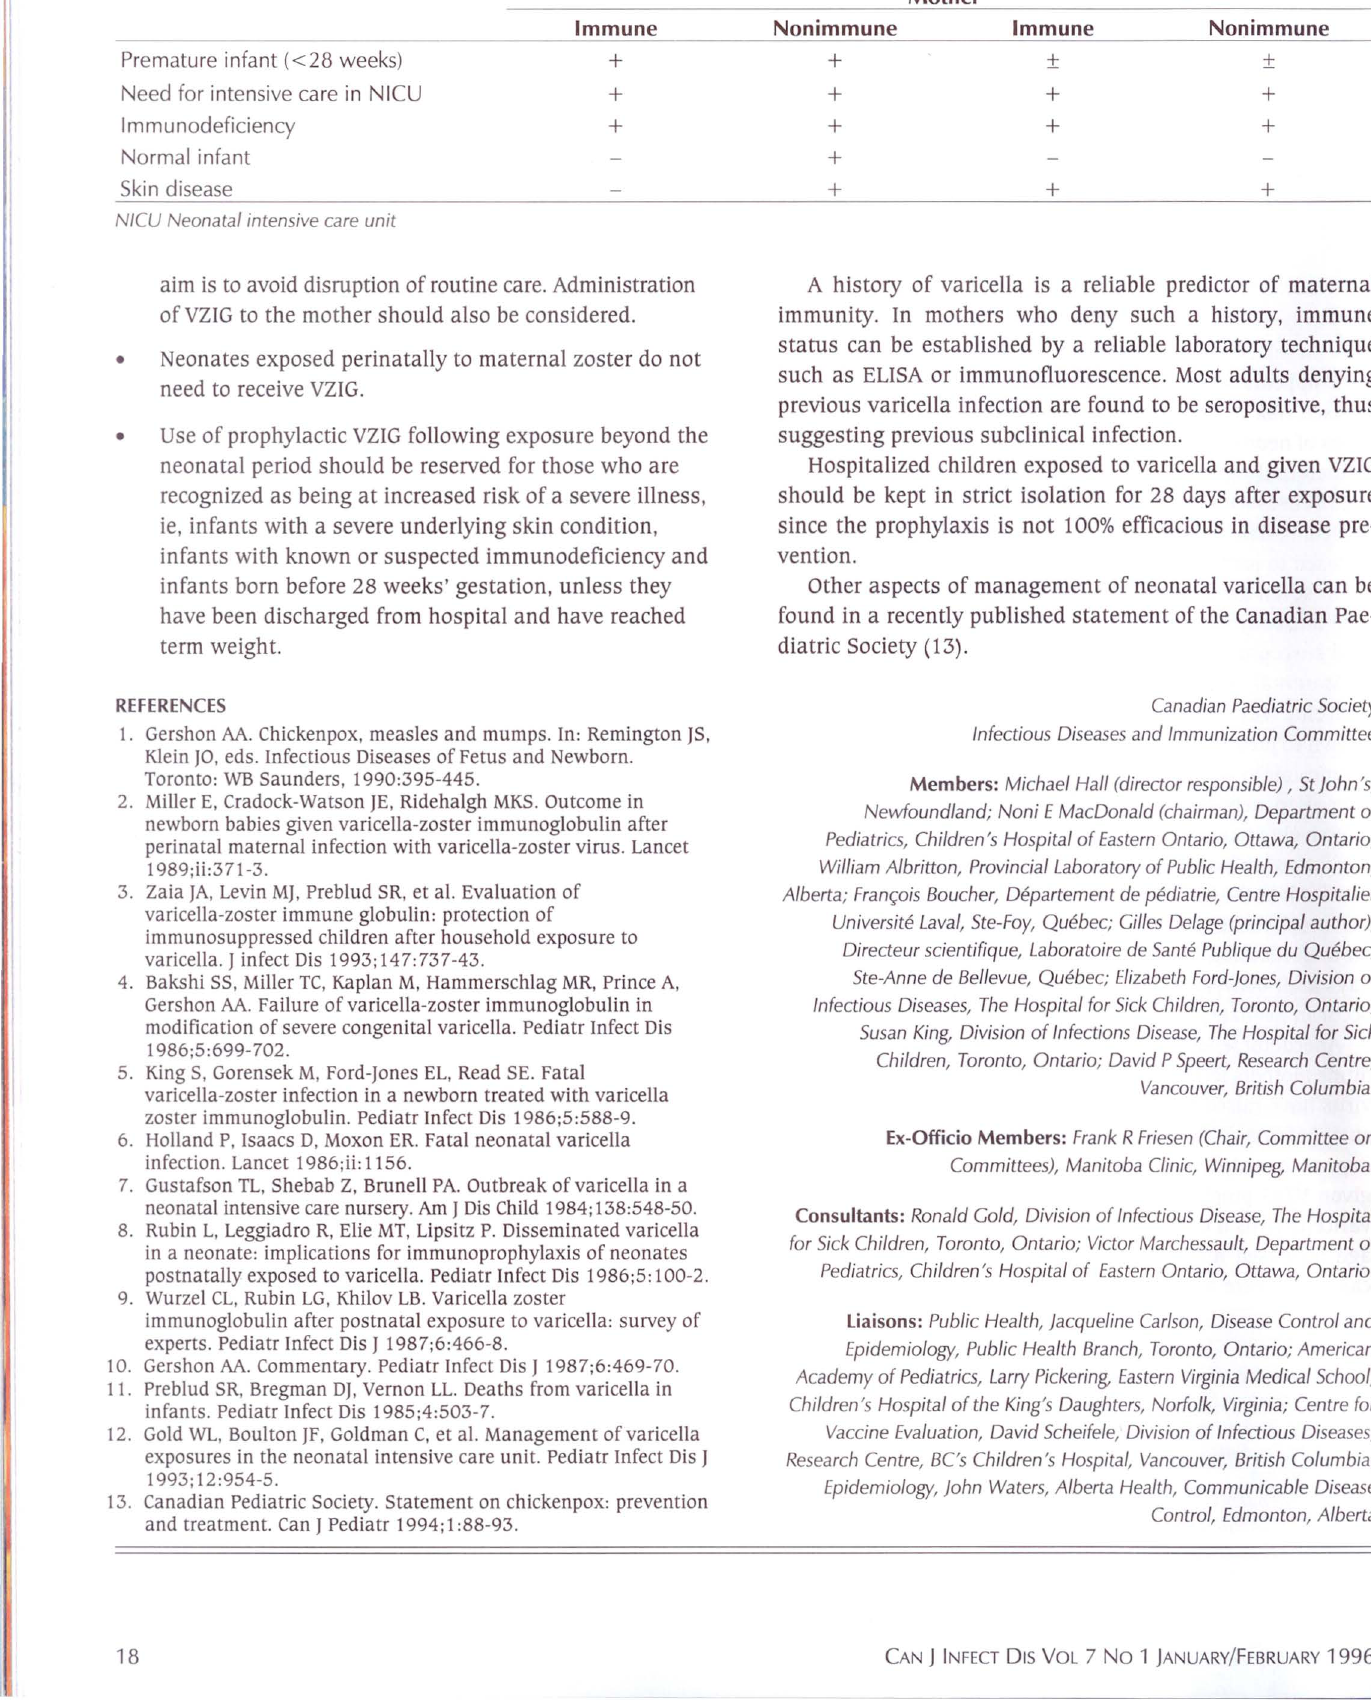
Neonates Immune + + +